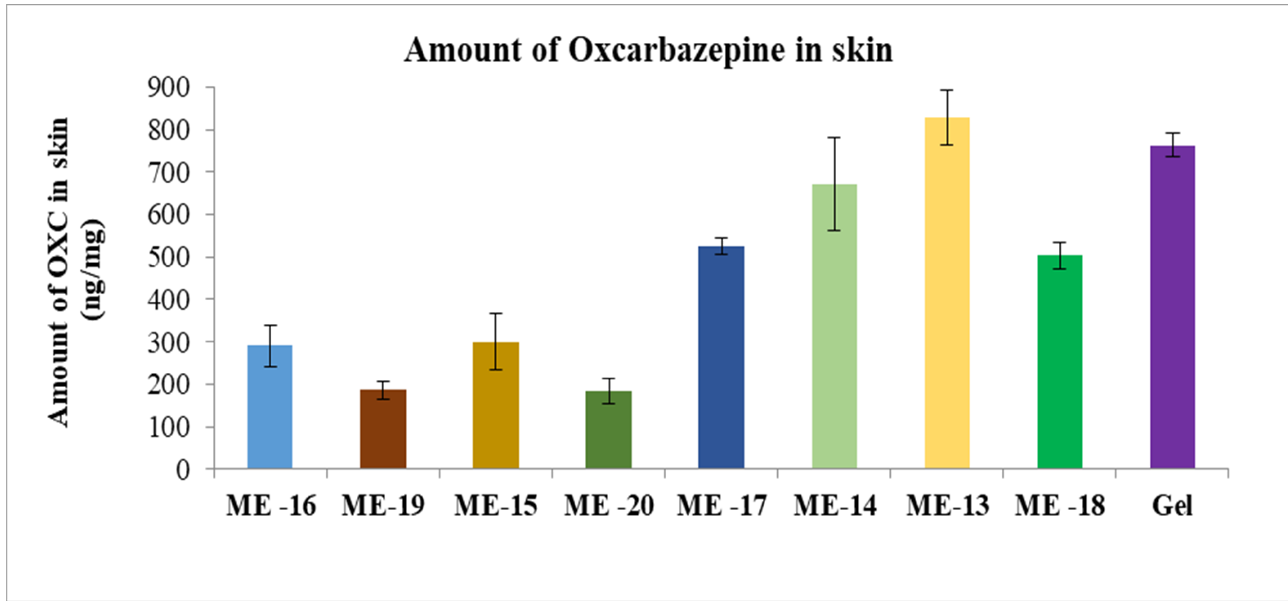
Figure 12. Amount of OXC deposited in the skin after 24 h of experiment. Each point represents the mean ± S.D. of three replicates in the absence of multiple donors.